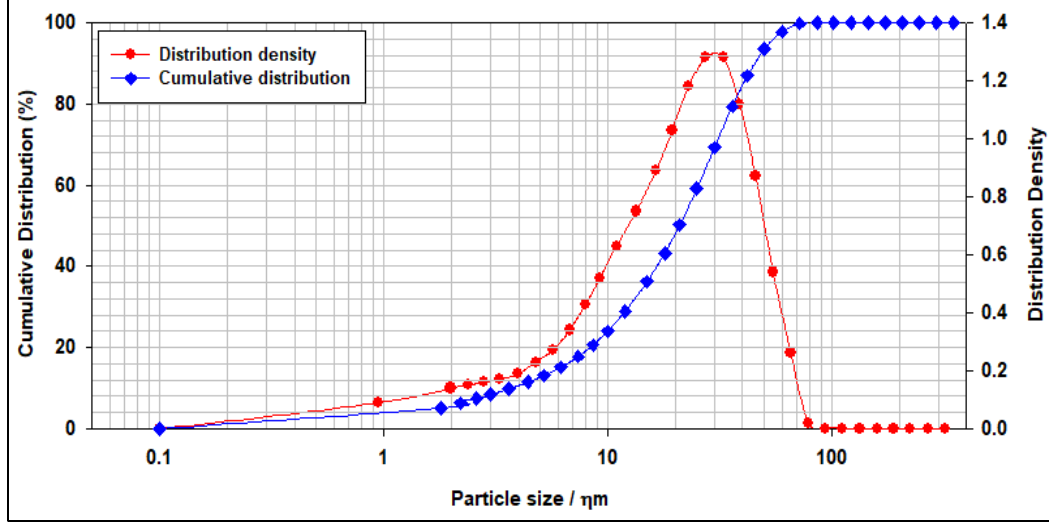
Figure 1. The particles size distribution of Saudi Class G cement.